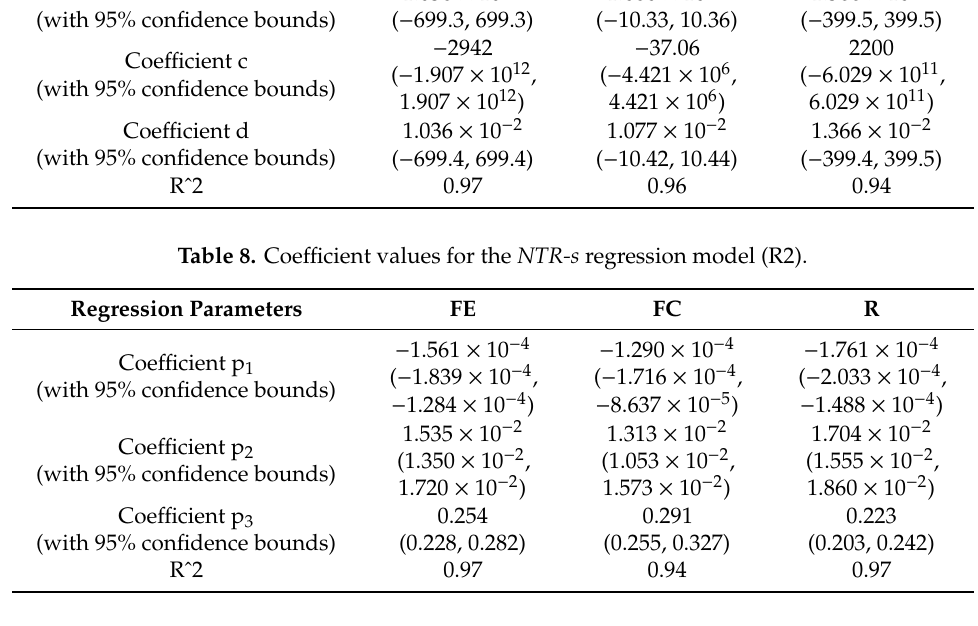
Table 9. Coe ffi cient values for the NTR- η T regression model